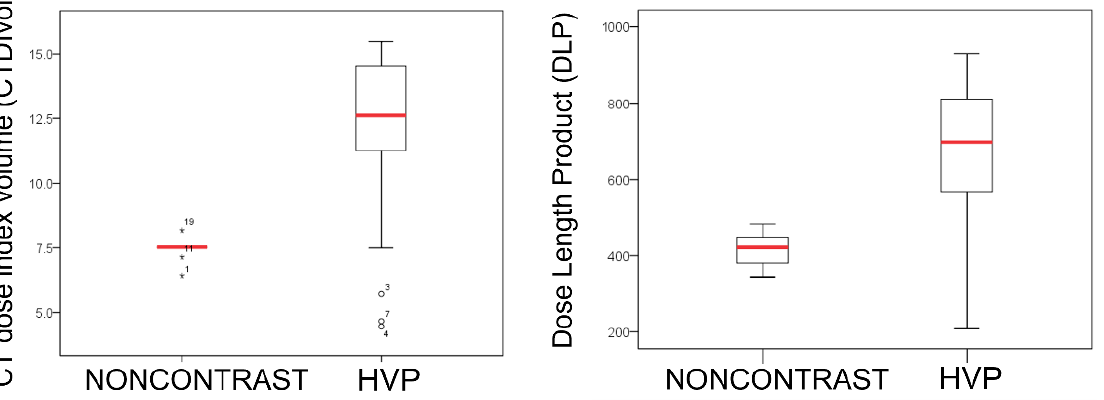
Figure 3. Graphs of CTDI volume and DLP in group B, with dose modulation turned on (HVP) and off (noncontrast).